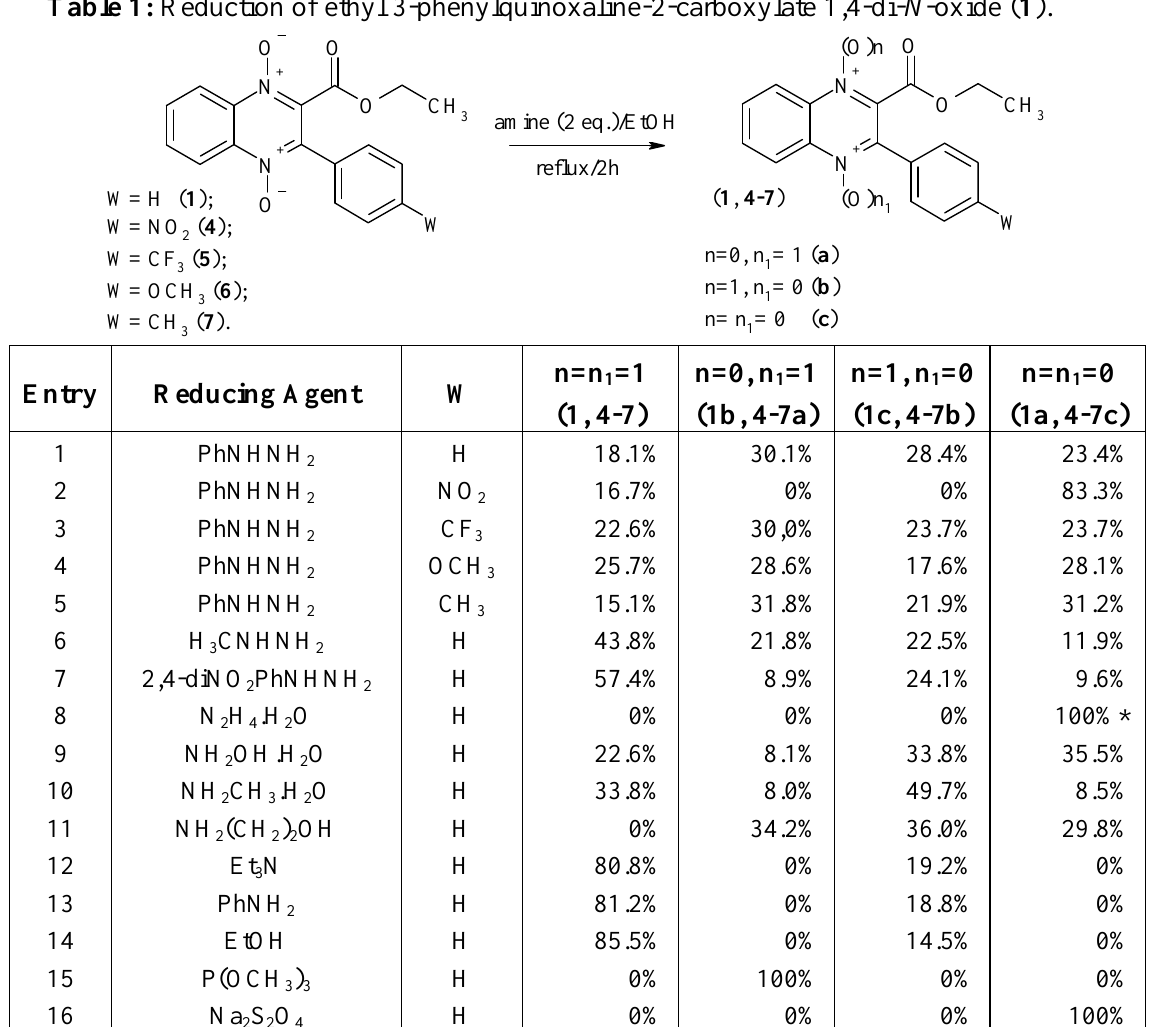
Table 1: Reduction of ethyl 3-phenylquinoxaline-2-carboxylate 1,4-di- N -oxide ( 1